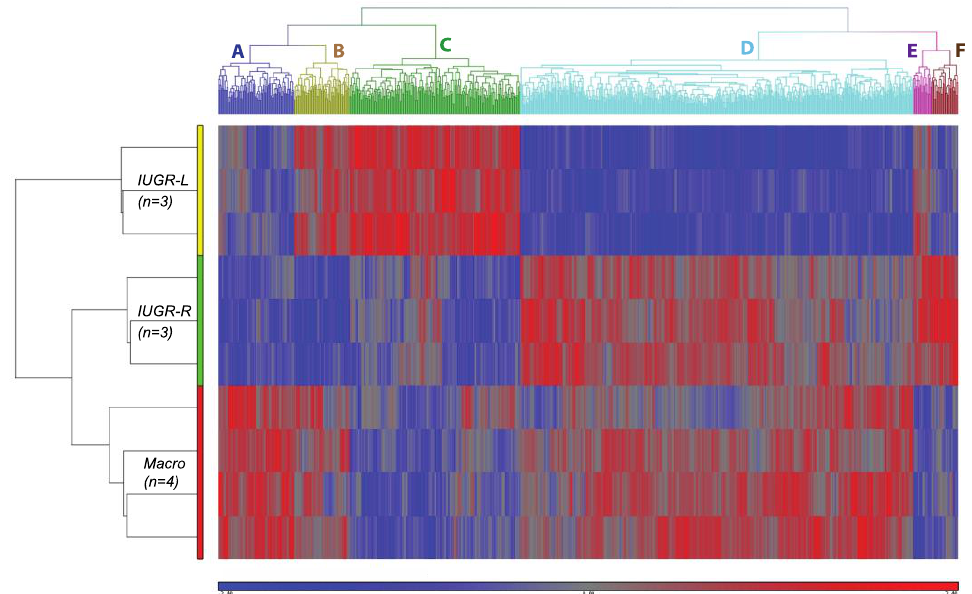
Figure 10. Unsupervised hierarchical clustering analysis of transcriptomes of gonadal fat. The heatmap shows differential expression of gene clusters in male adipose tissue from IUGR-L (first three rows; yellow bar), IUGR-R (center three rows; green bar) and macrosomic (“Macro”, last four rows; red bar) groups. Each column represents a gene and each row represents a different animal. Red indicates up-regulation and blue indicates down-regulation; grey indicates unchanged expression. Six clusters were identified (A–F at top). Genes were identified by ANOVA and were significant at p < 0.01.